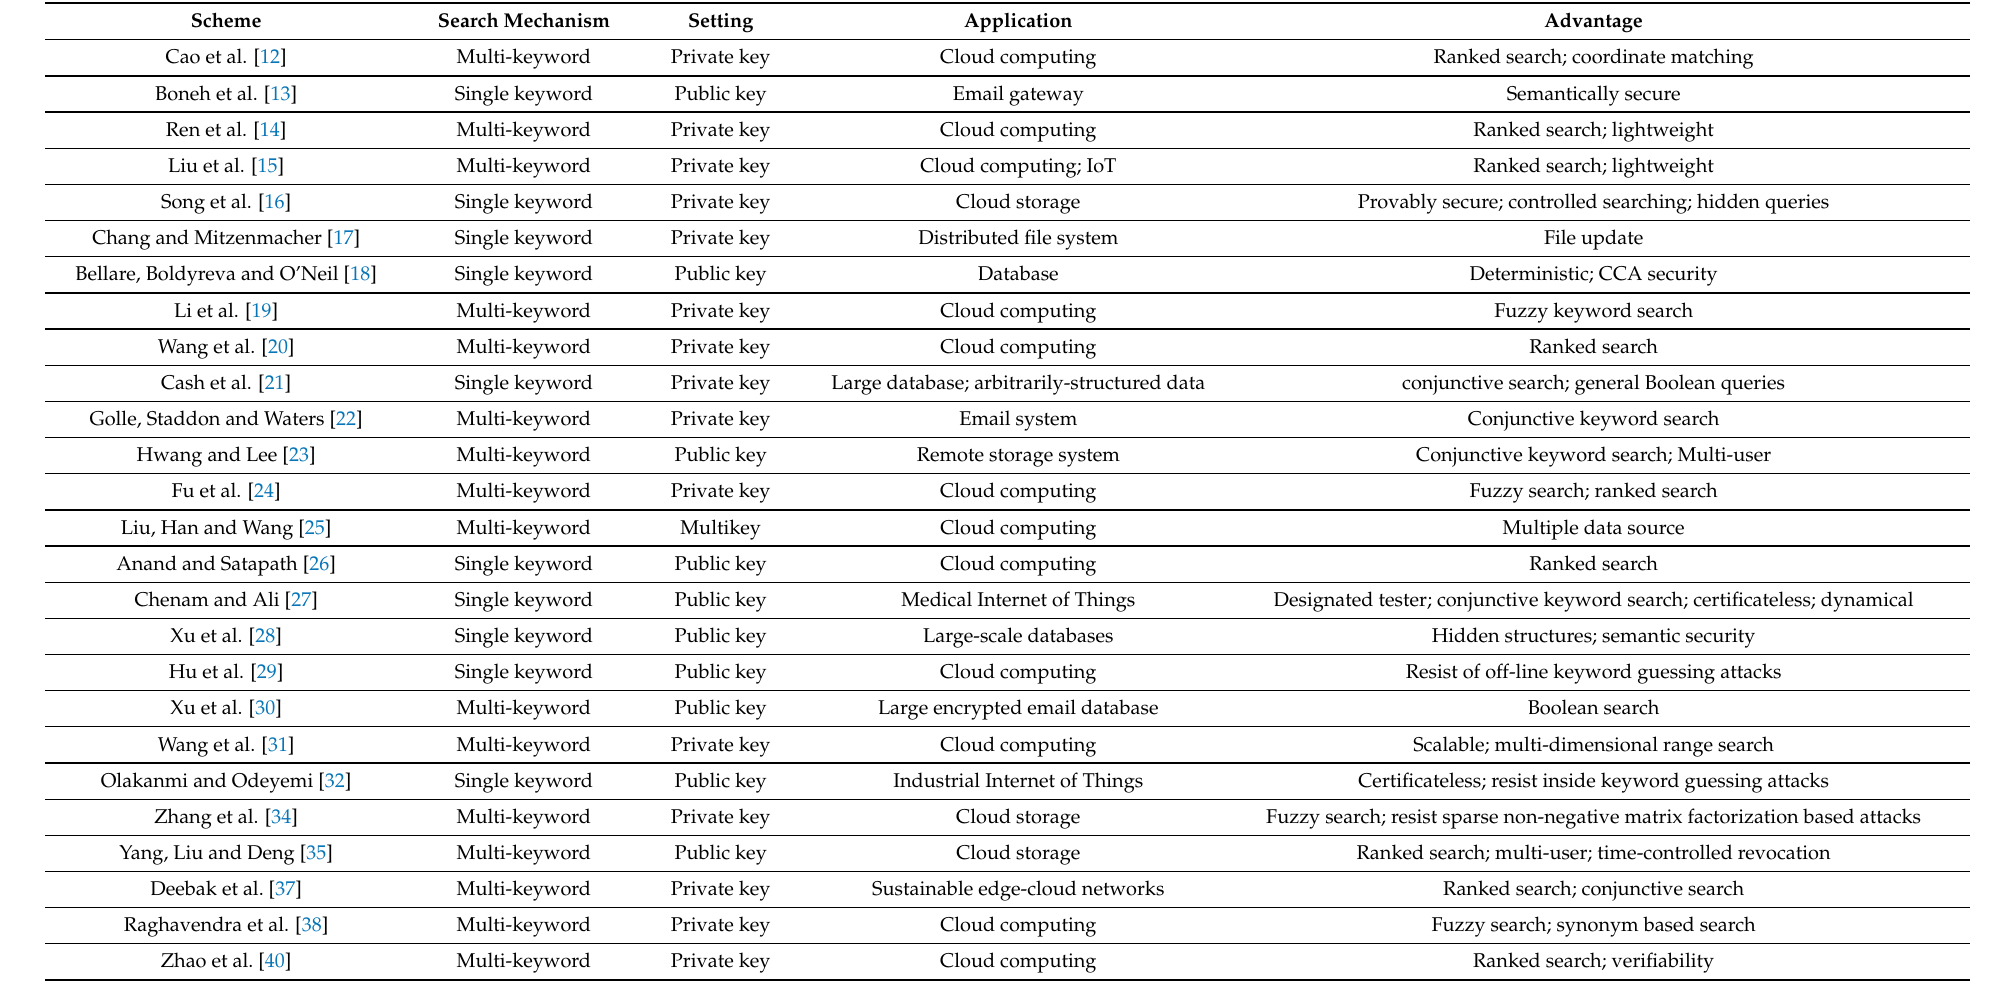
Table 1. Comparison with related